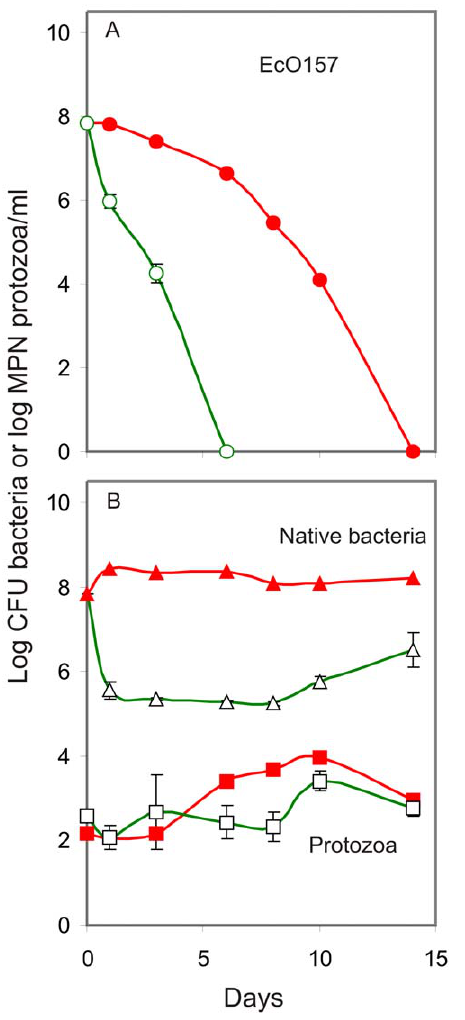
Figure 1. Survival of EcO157 in dairy wastewater treated with monensin. EcO157 populations (top panel) were monitored in wastewater treated with (red filled circle) or without (green open circle) monensin. Aerobic bacteria (triangles) and native protozoa (squares) in the presence (red, filled symbols) or absence (green, open symbols) of monensin were also monitored (bottom panel). The monensin-treatment replicate (panel A, red line) with extended survival of EcO157 was chosen for characterization of protozoan and bacterial communities by 18S and 16S rRNA gene sequencing. Corresponding data for total bacteria and protozoa for the replicate are plotted (bottom panel, red lines). Standard deviations for averages of triplicates for untreated wastewater are shown. Replicate differences in survival of EcO157 in monensin-treated wastewater are shown in Figure S1.